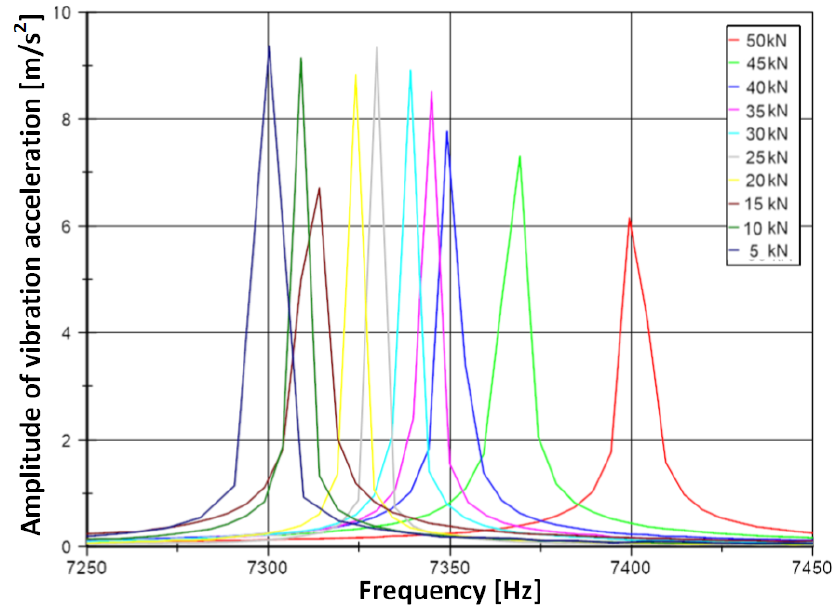
Figure 7. Detailed frequency spectrum of the signal in range 7250–7450